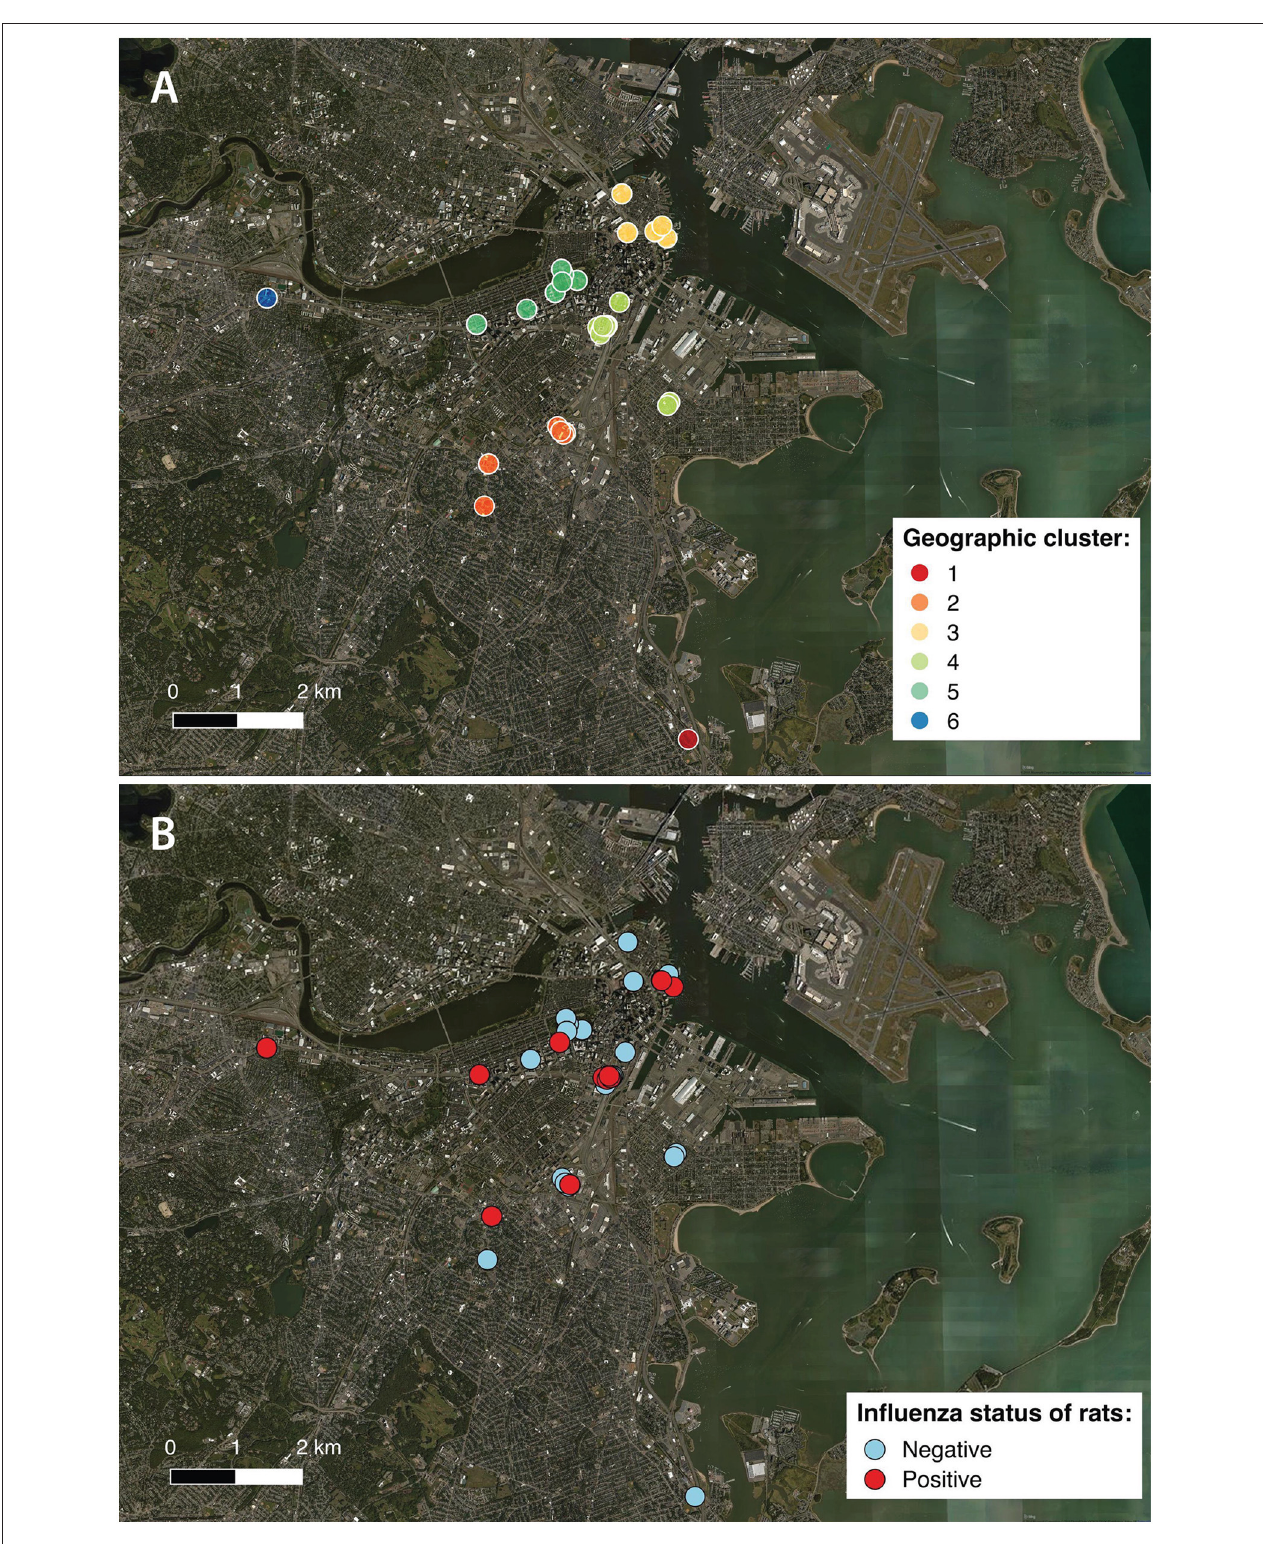
FIGURE 1 | Locations of individual sampling sites within the City of Boston, color coded according to (A) the 6 geographical clusters (“geoclusters”) identified with k-means clustering, a process that grouped rat sampling sites according to geographic proximity based on latitude and longitude; (B) influenza A virus status of rats based on molecular screening (positive or